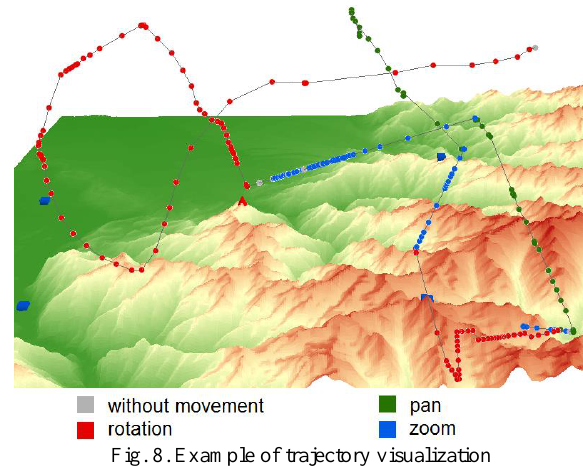
Fig. 8. Example of trajectory